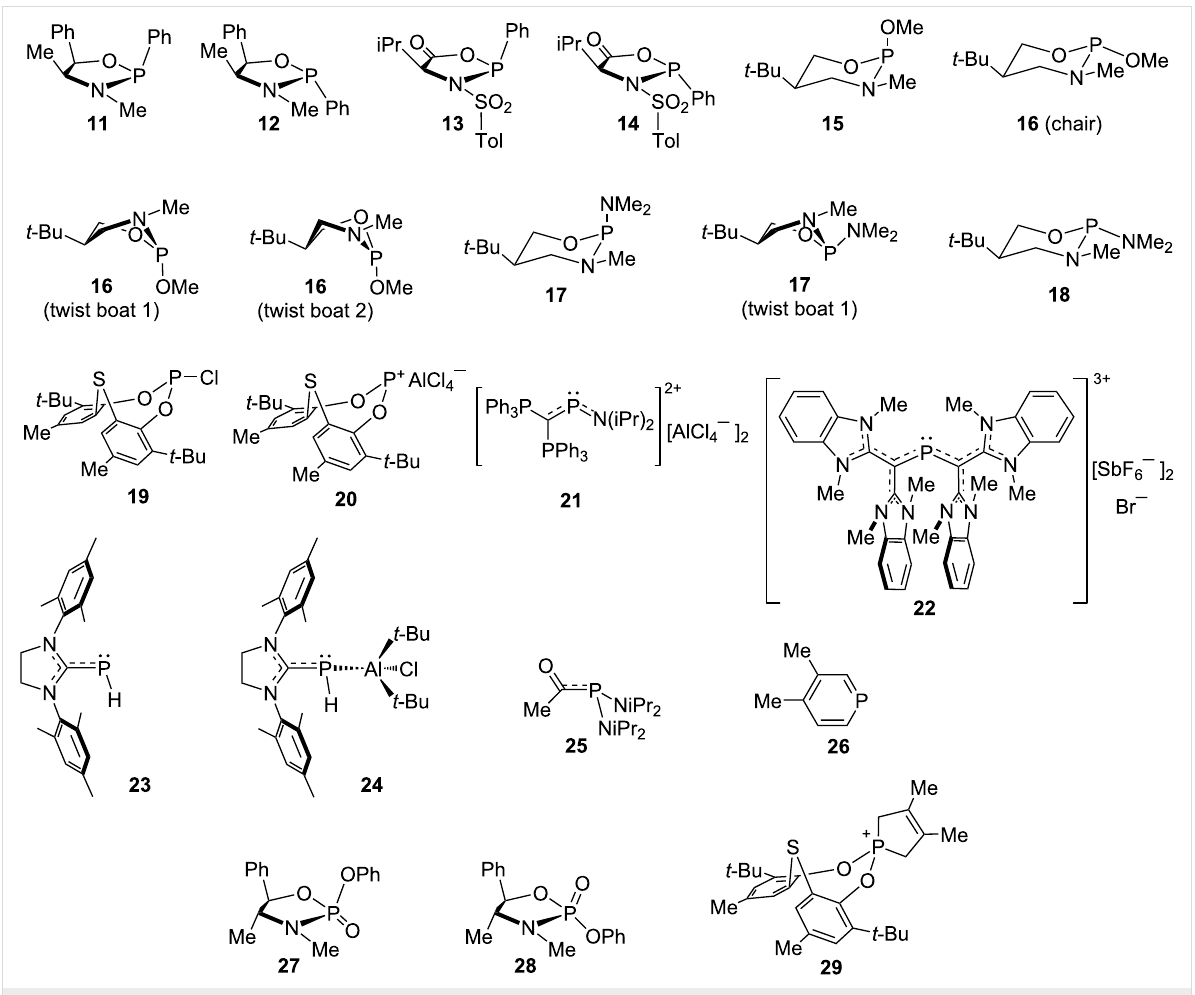
Figure 5: Stereoisomers and unusual phosphorus compounds used for chemical shift calculations.